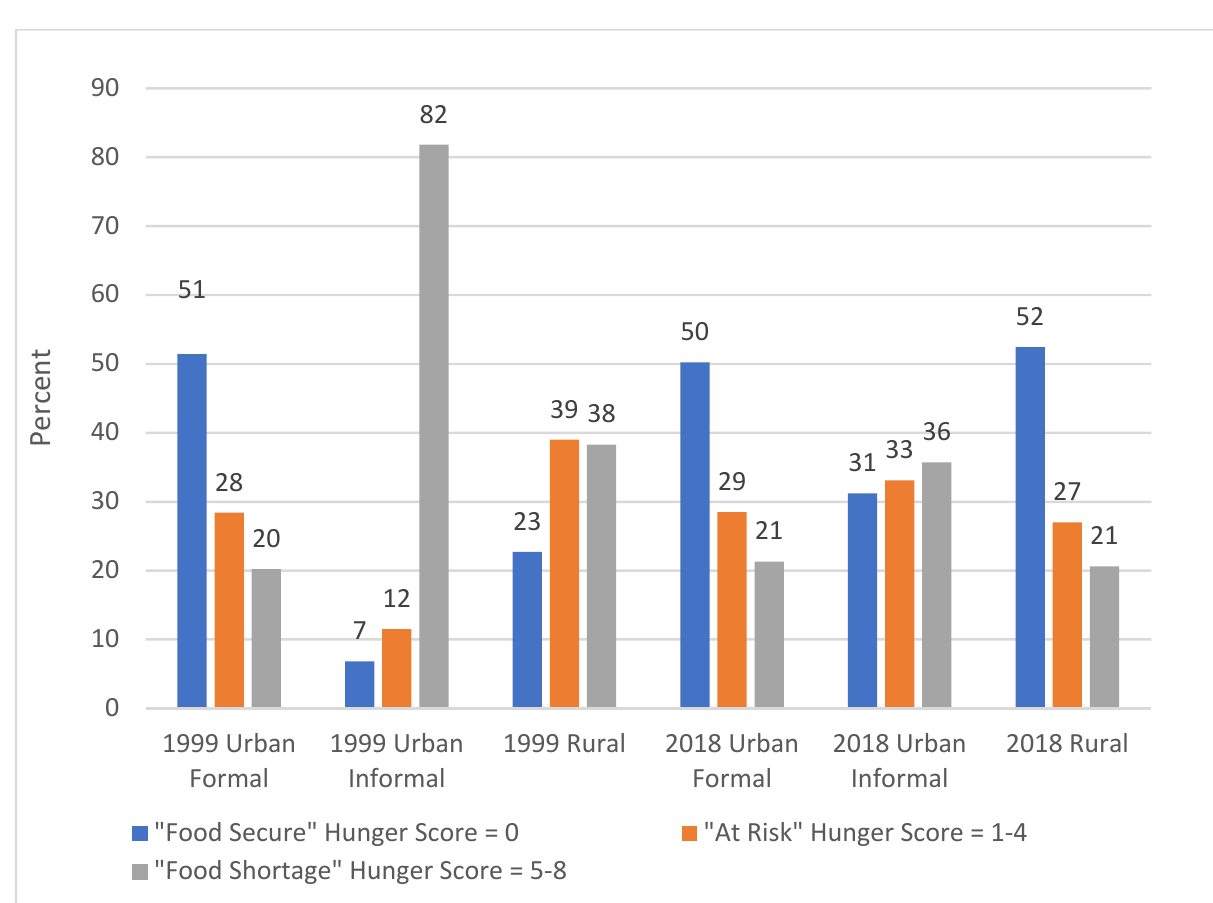
Figure 2. Percent households in Western Cape with different hunger scale categories (values rounded to nearest whole number).